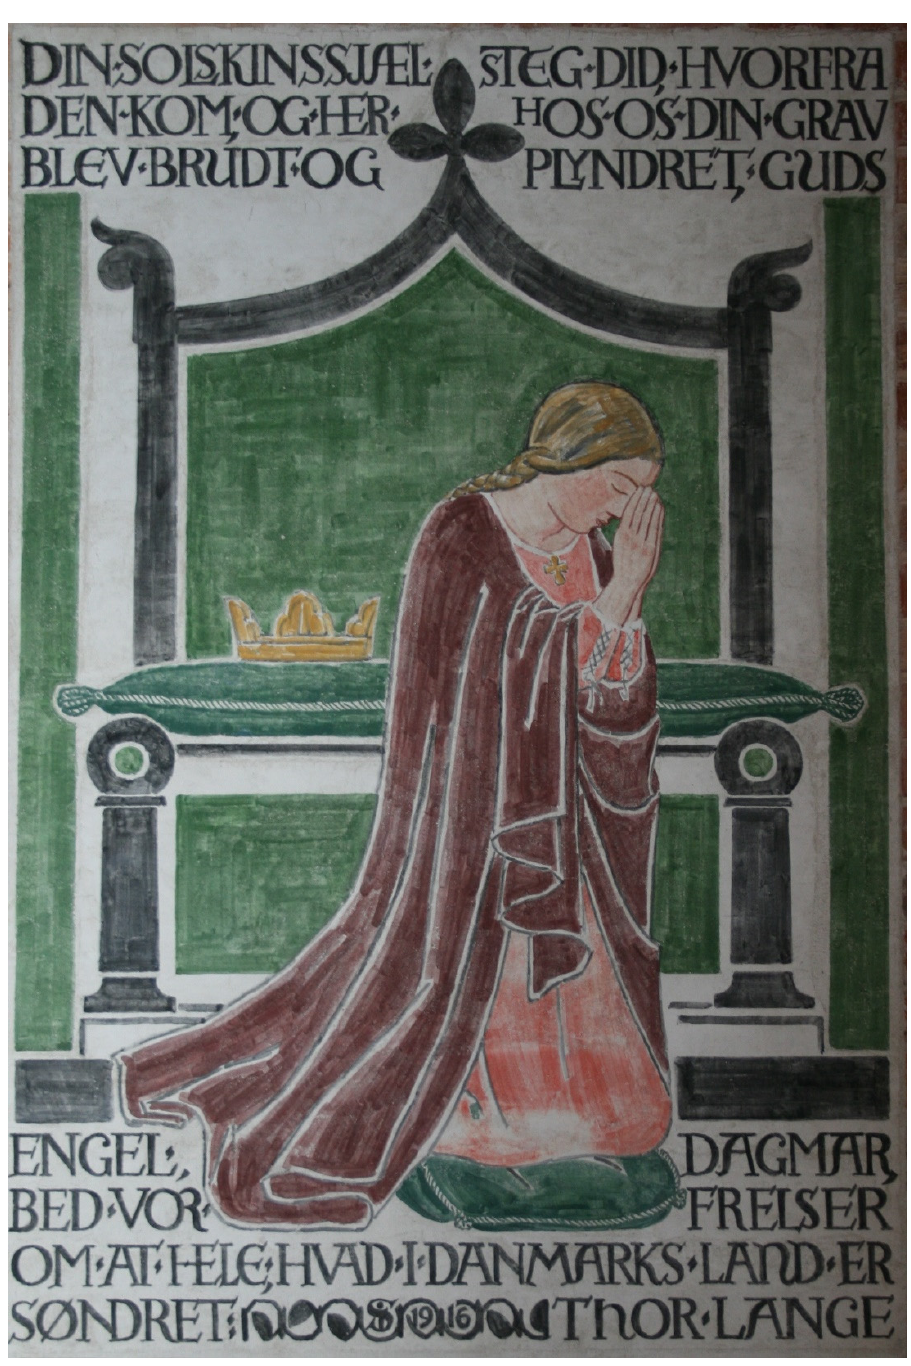
Figure 1. Queen Dagmar in Ringsted. Photo Martin Wangsgaard Jürgensen.